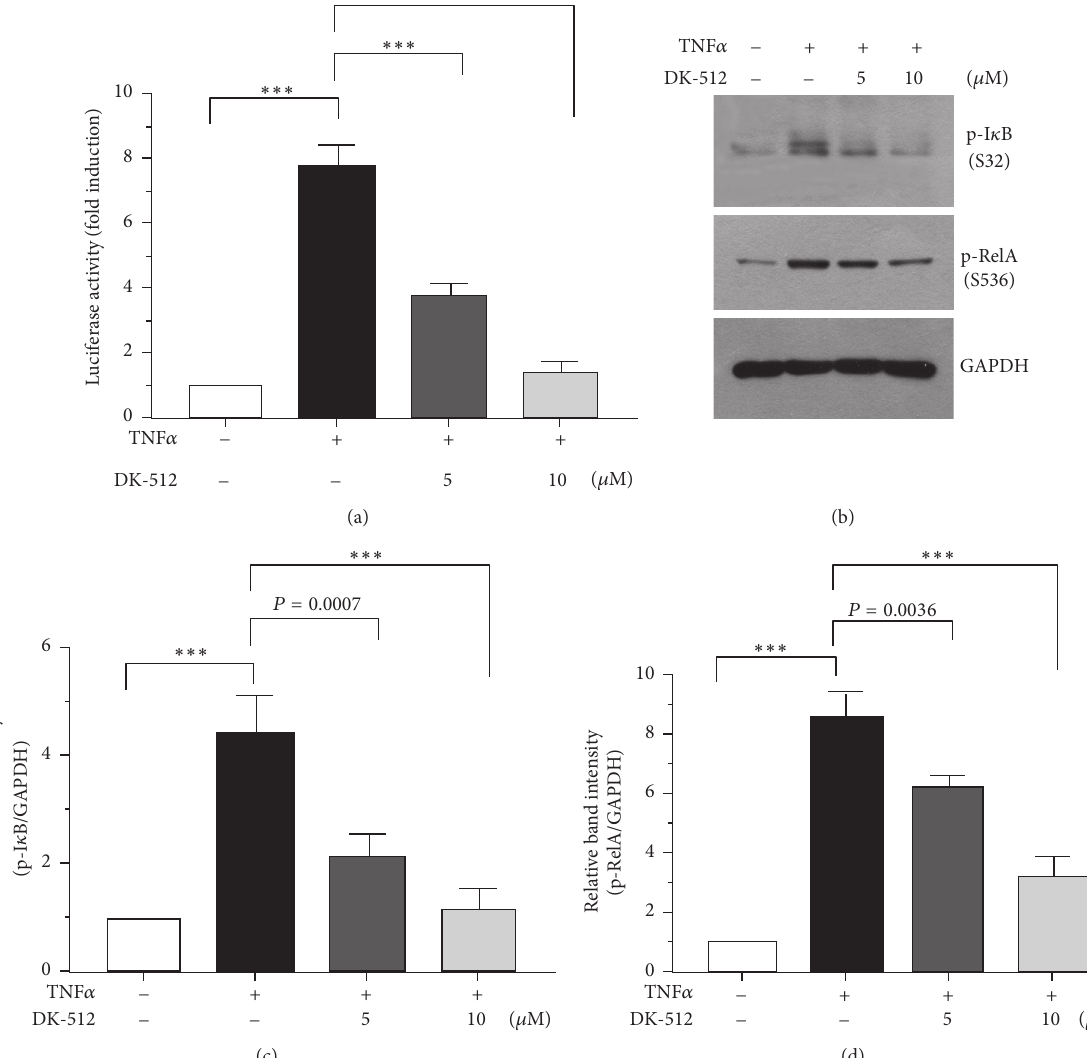
Figure 5: Effect of DK-512 on the inhibition of TNF 𝛼 -induced NF- 𝜅 B activation. (a) MDA-MB-231 cells were transfected with cis- acting 5x NF 𝜅 B-Luc plasmid along with 50 ng pRL-null. After 48 h, cells were treated with or without 10ng/mL TNF 𝛼 in the absence or presence of 5 or 10 𝜇 M DK-512. The data shown represent the mean ± SD. ∗∗∗ 𝑃 < 0.0001 ( 𝑛 = 3 ). P value was analyzed by Sidak’s test. (b) MDA-MB-231 cells were incubated with 0.5% FBS for 24h, followed by pretreatment with 5 or 10 𝜇 M DK-512 for 30 min before stimulation with 10ng/mL TNF 𝛼 . After 30 min, whole-cell lysates were prepared and immunoblotting was performed using the phosphospecific antibody against I 𝜅 B 𝛼 (Ser32) or RelA NF- 𝜅 B (Ser536). The anti-GAPDH antibody was used as an internal control. The relative band intensities of p-I 𝜅 B (c) and p-RelA (d) in (b) were measured using ImageJ software. The data shown represent the mean ± SD ( 𝑛 = 3 ). ∗∗∗ 𝑃 < 0.001 . P value was analyzed by Sidak’s